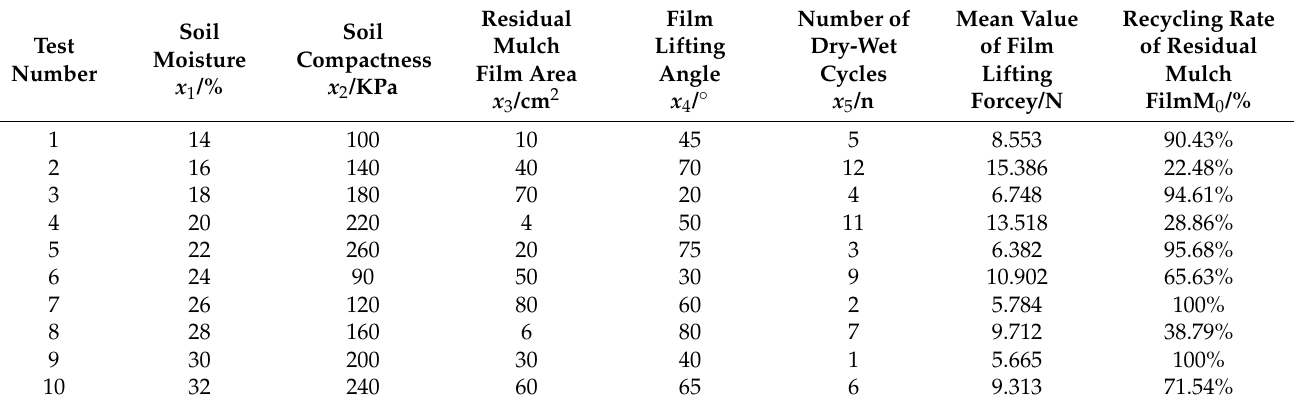
Table 2. Uniformity test